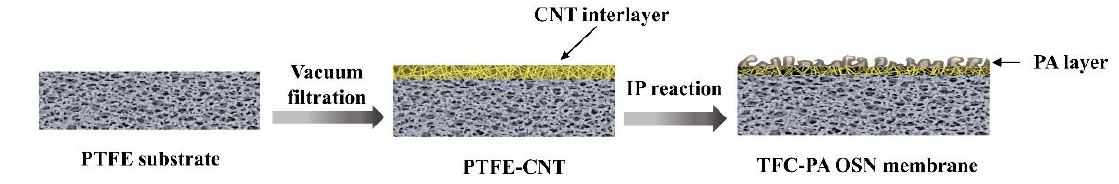
Figure 1. Schematic illustration of the preparation process of PTFE-CNT-PA membrane.